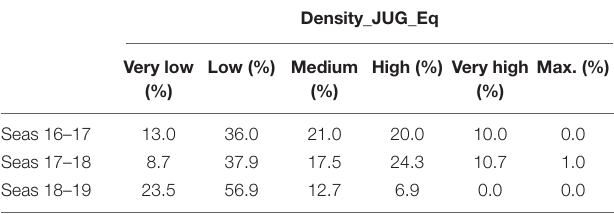
TABLE 8 | Contingency table: Season * Density of players of the observed team.